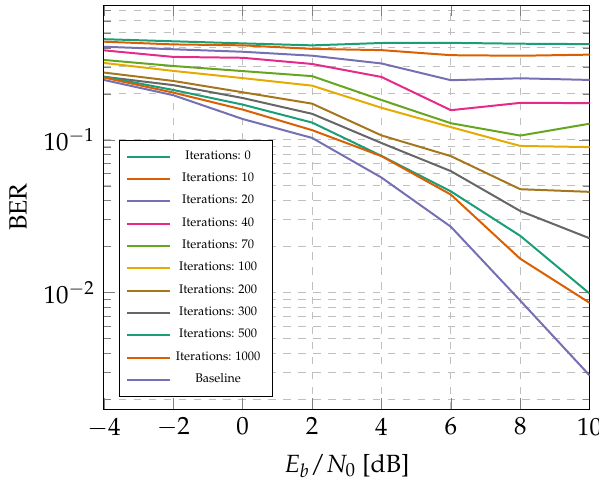
Figure 11. BER over SNR for different number of training